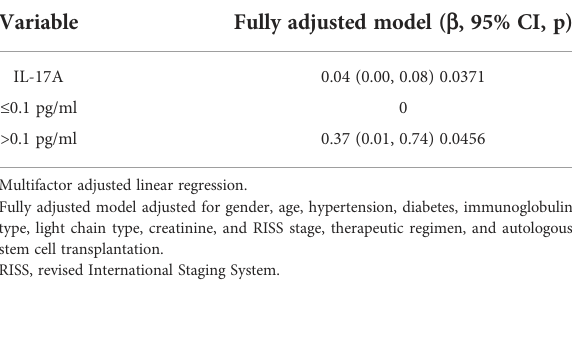
TABLE 4B Multiple regressions analyses between serum IL-17A and best overall effect (BOE) in different immunoglobulin types.